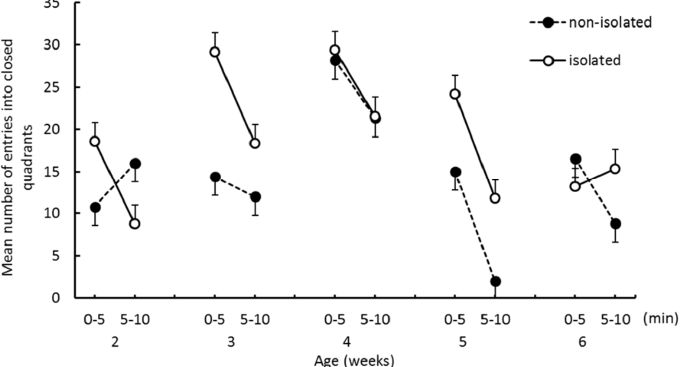
Figure 3. The mean time spent in the closed quadrants during the EZM test. Error bars indicate the standard error.